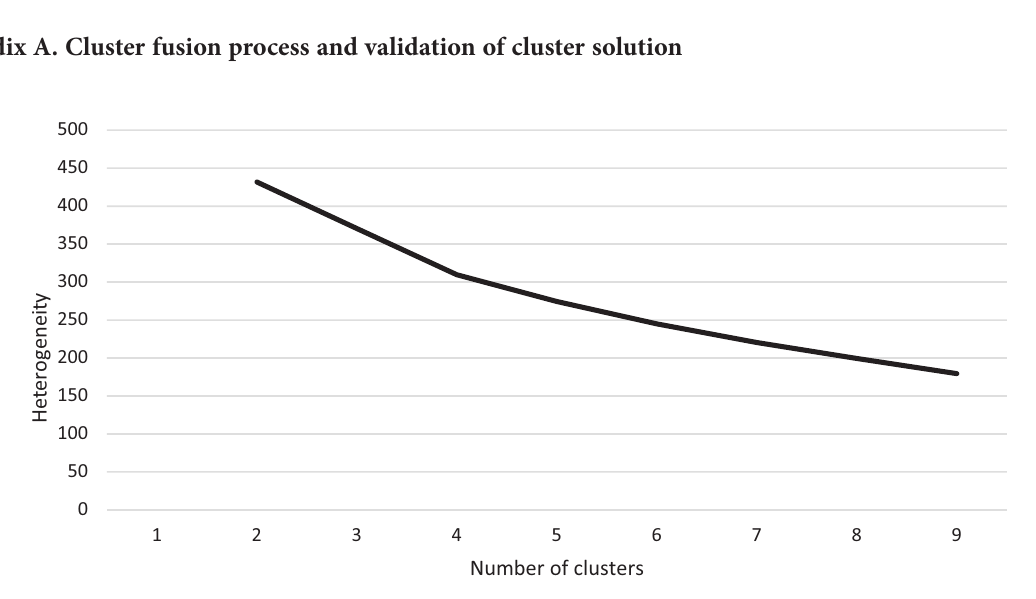
Figure A1. Elbow criterion to determine optimal cluster count. Cluster heterogeneity measured by coefficients during fusion process (ordinate) and possible cluster solutions